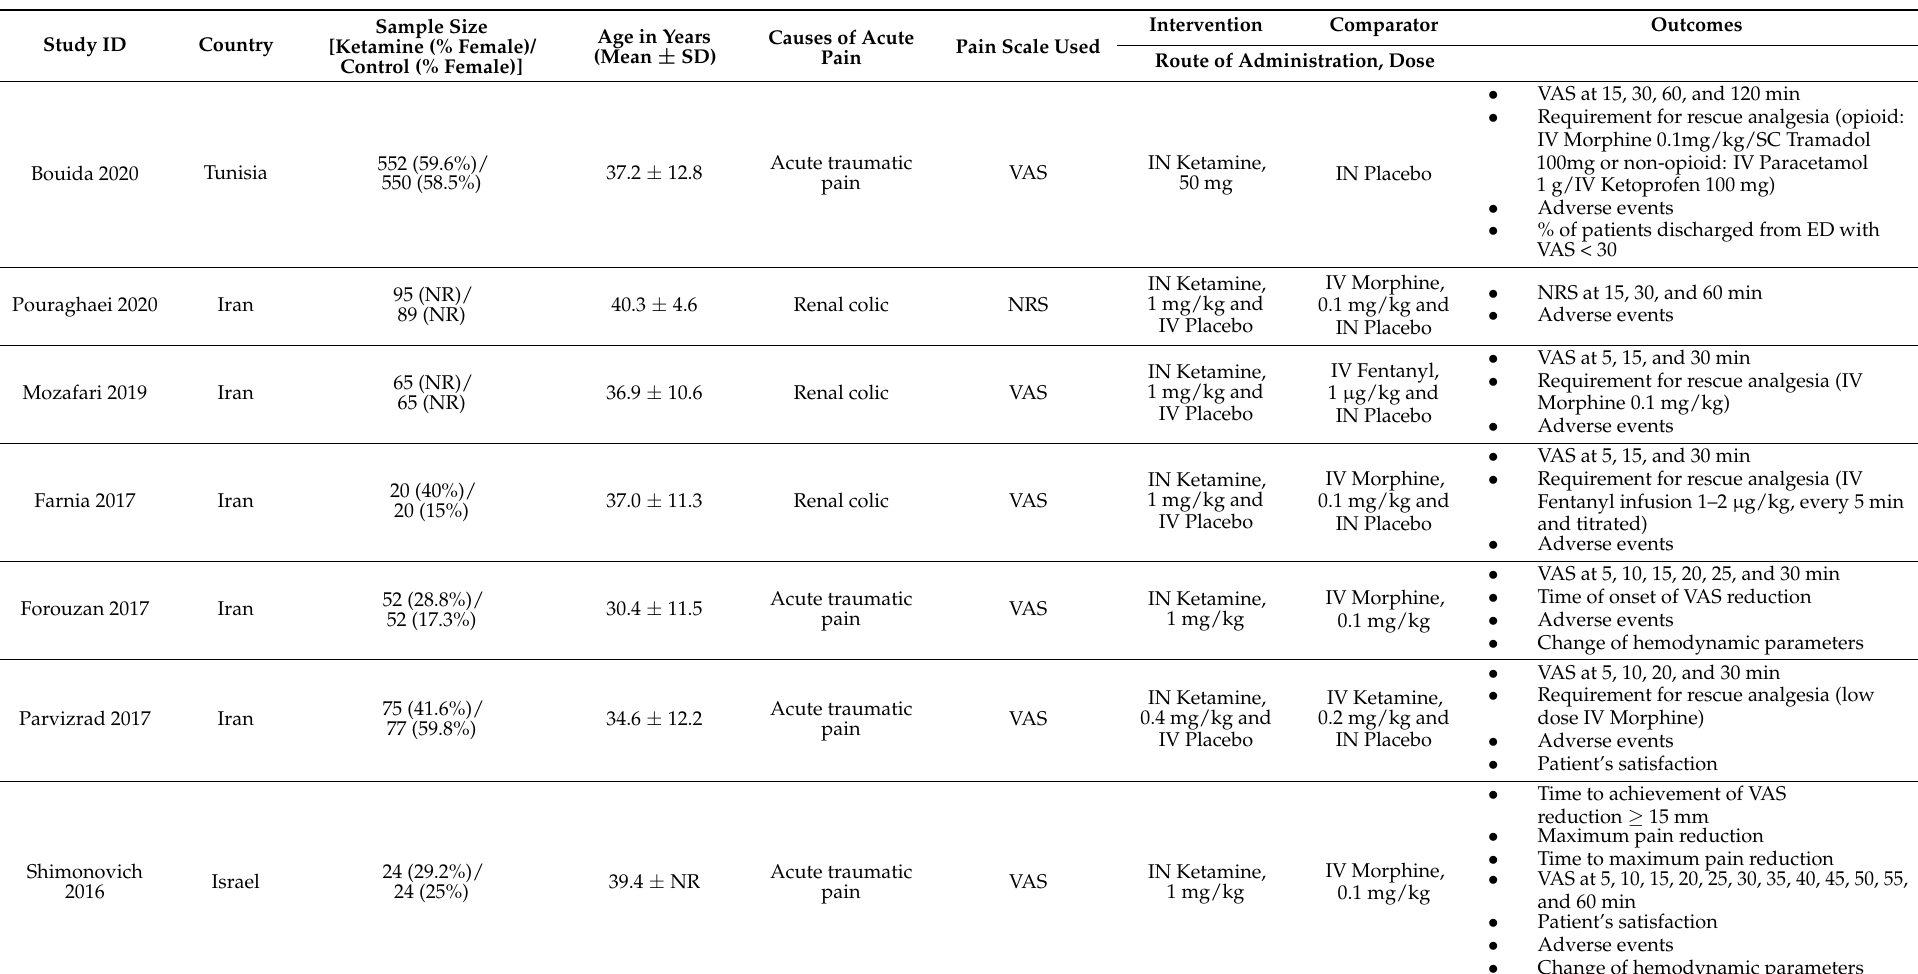
Table 1. Major characteristics of the included